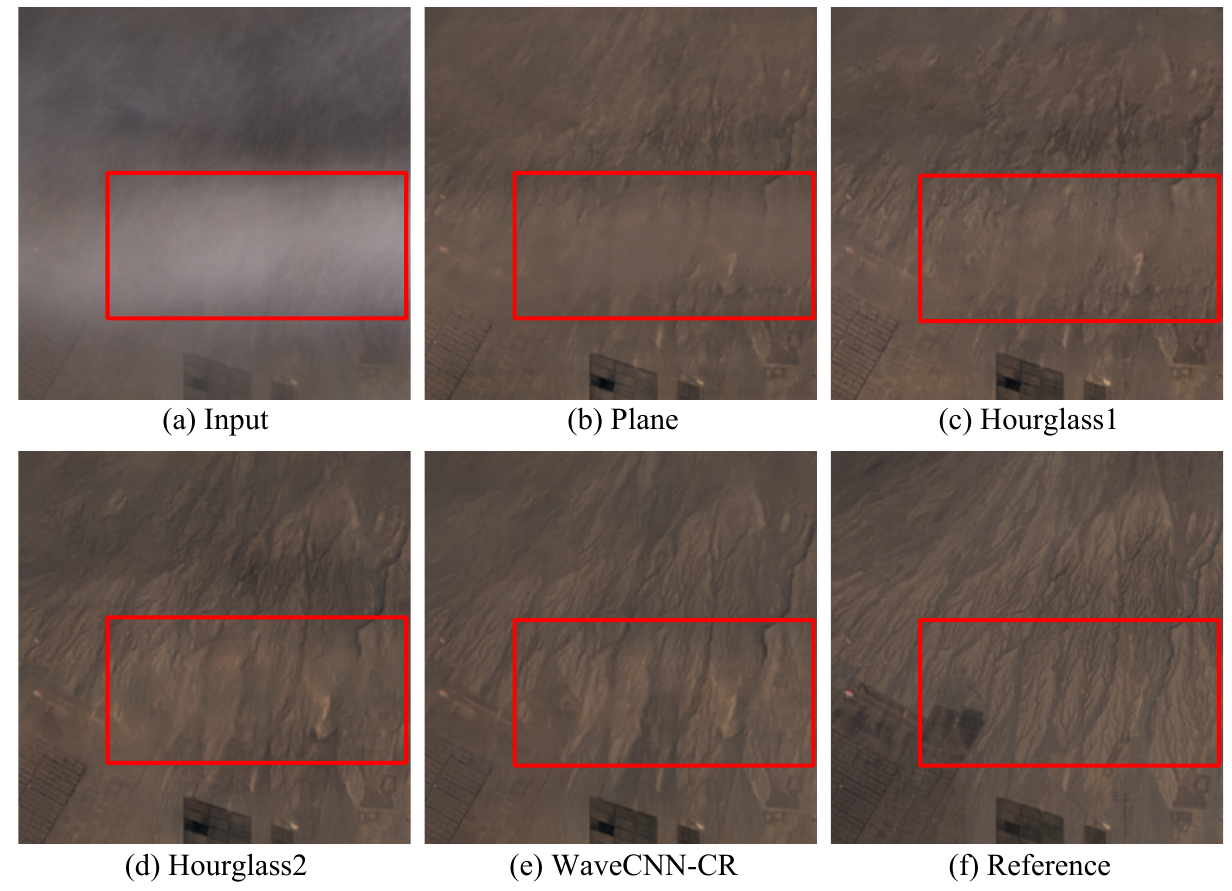
Figure 4. Visual comparisons of different network architectures: ( a ) input cloudy image; ( b – e ) respec- tive results of Plane, Hourglass1, Hourglass2, and WaveCNN-CR; ( f ) reference cloud-free image.